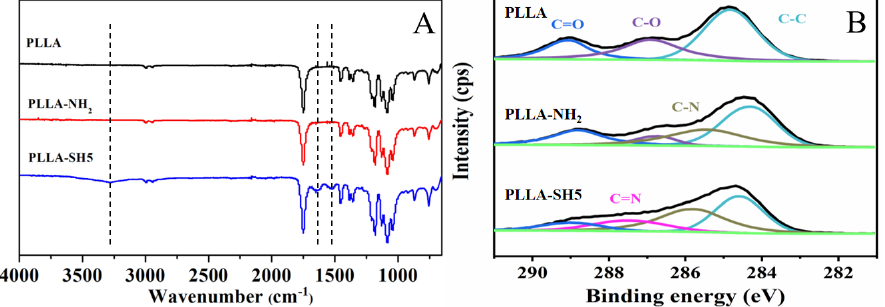
Figure 5. Characteristics of the modified PLLA membrane. ( A ) FT-IR spectrogram and ( B ) XPS.